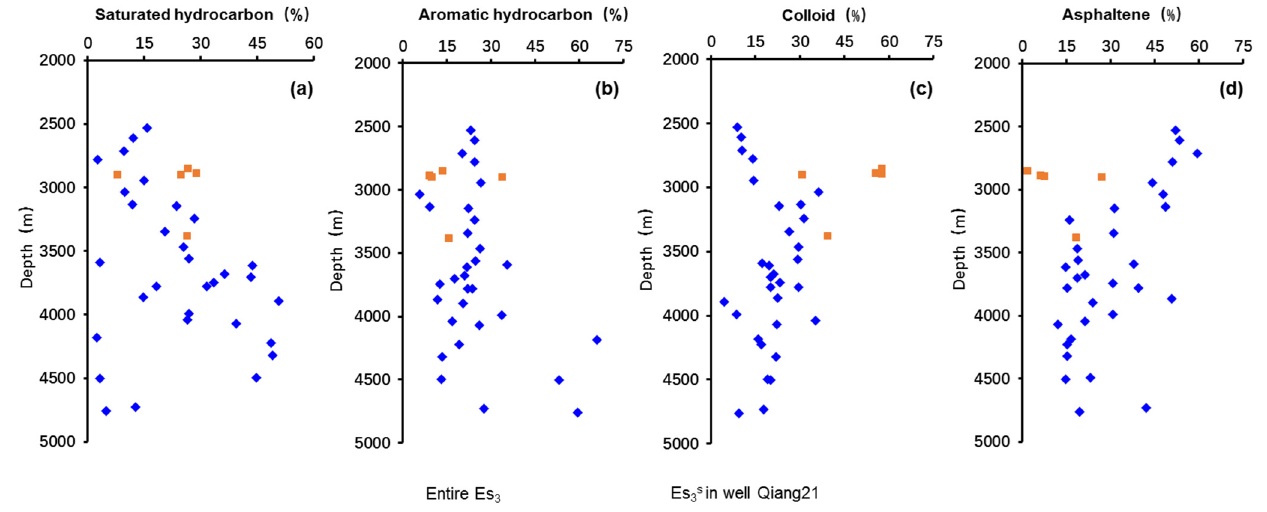
Figure 13. Relationships of shale oil compositions—( a ) saturated hydrocarbon, ( b ) aromatic hydrocarbon, ( c ) colloid, ( d ) asphaltene—with burial depth.